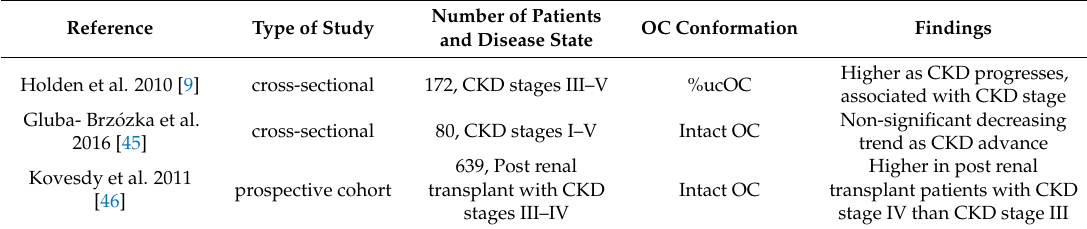
Table 5. Variations of serum OC levels in human